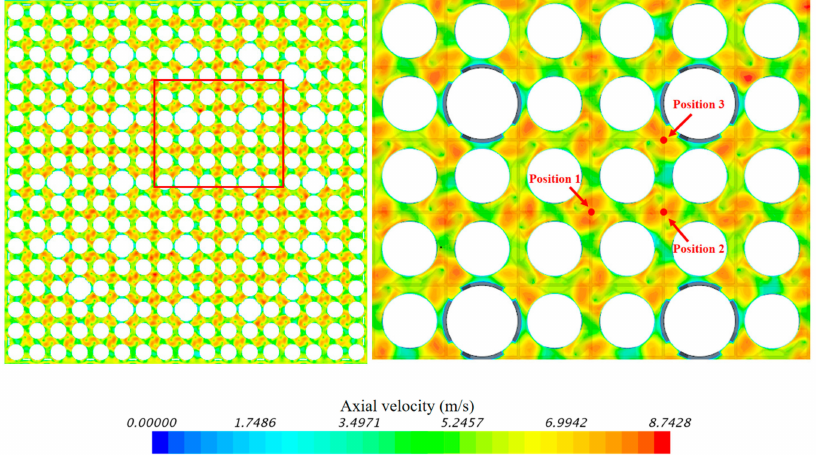
Figure 14. Location of the monitoring points.